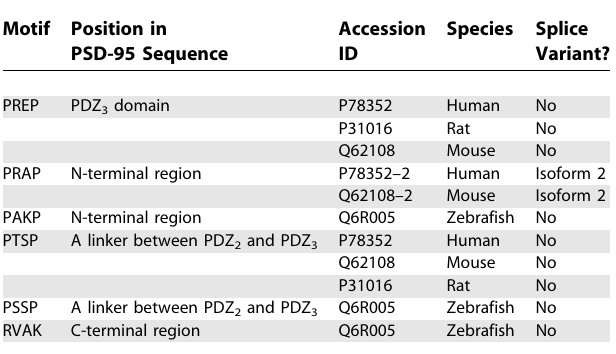
Table 2. Cross-Species Analysis of PXXP Motif in PSD-95 Proteins Motif Position in PSD-95